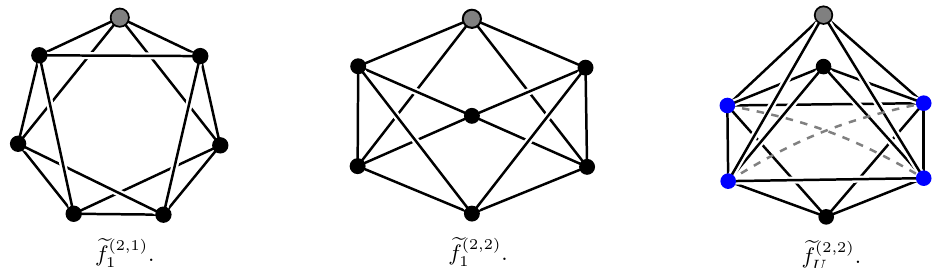
Figure 3. Here we draw some examples of e f -graphs, e f (2 , 1) , f (3) , f (3) f (3) 1 3